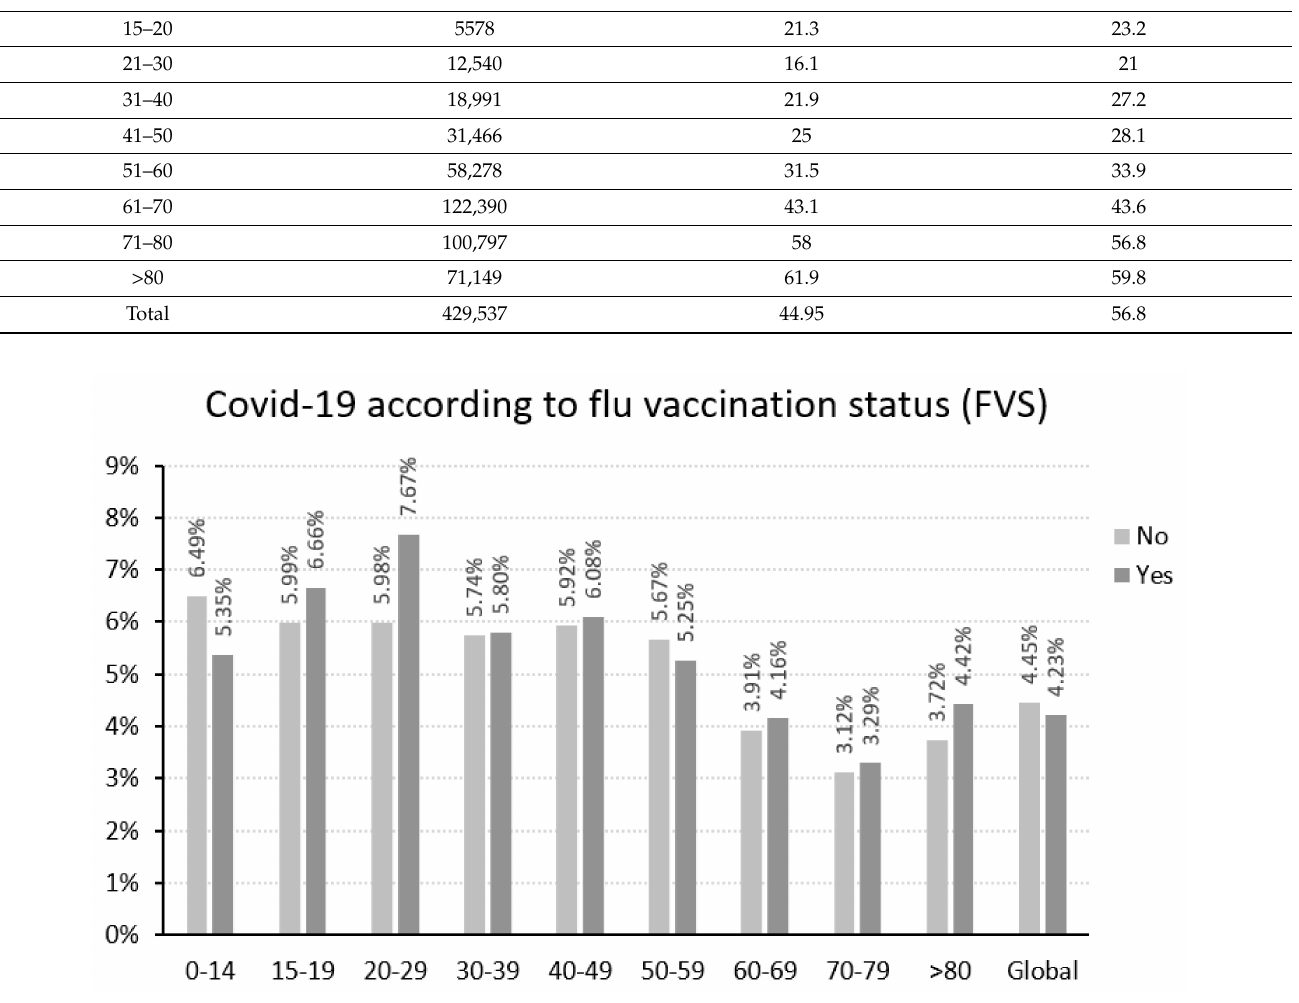
Figure 1. Probability of contracting COVID –19 depending on whether the patient had received the flu vaccine. Table 2. Probability of SARSCoV-2 infection, based on flu vaccination status (FVS), stratified by age (over or under 60 years of